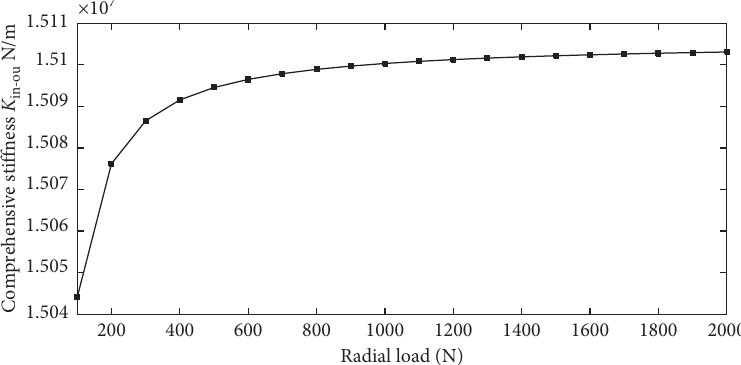
Figure 8: Comprehensive stiffness under different loads.